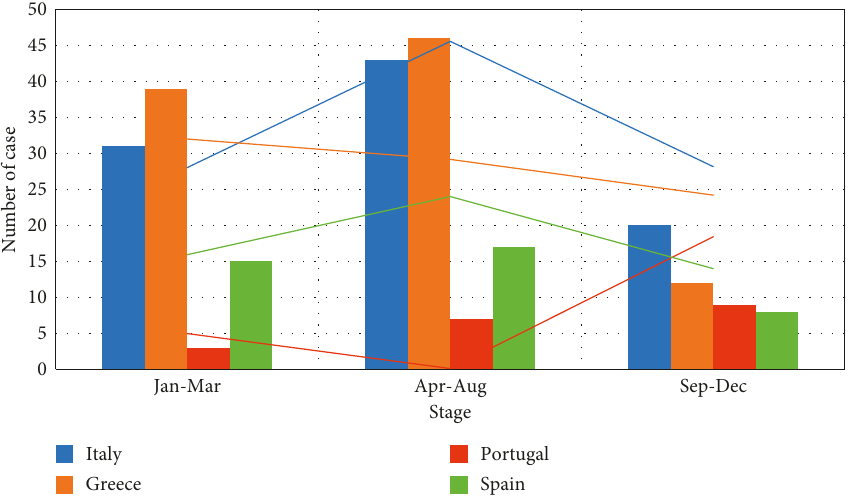
Figure 6: High incidence rate ConvLSTM model forecast results chart (every 4